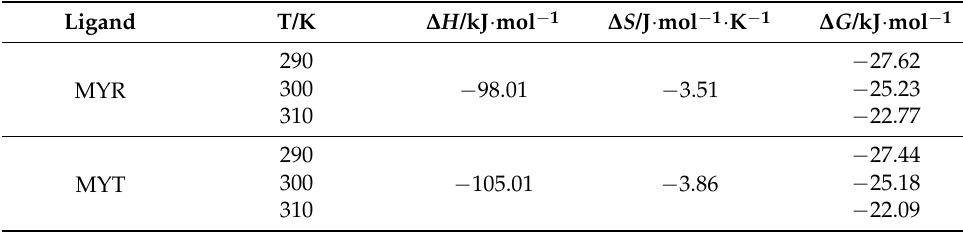
Table 2. Calculated thermodynamic quantities including enthalpy, entropy and Gibbs free energy changes shown with ∆ H , ∆ S and ∆ G , respectively, for the PK-MYR and PK-MYT complexes.